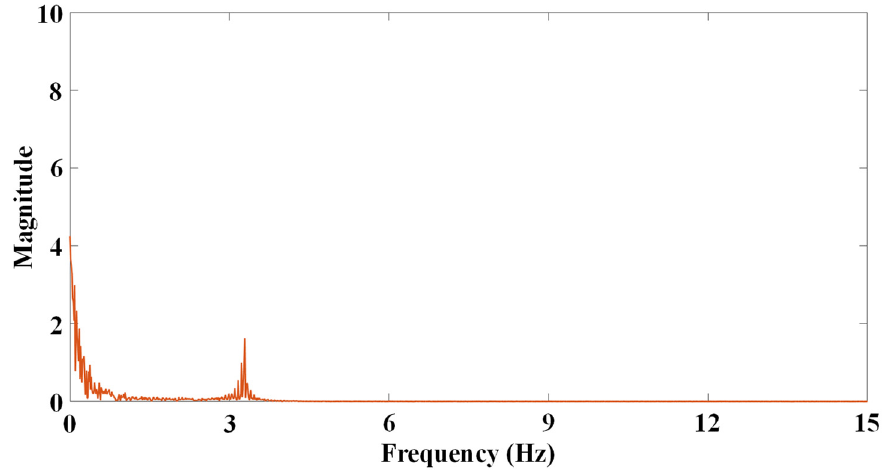
Figure 7. Processed signal of FT.